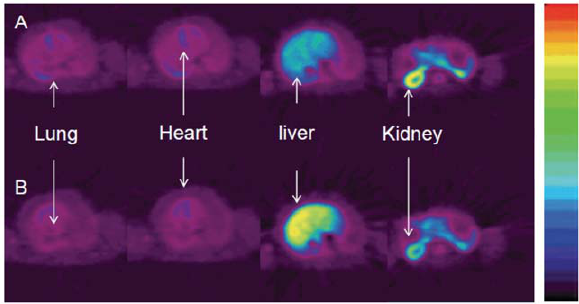
Figure 1. Summed images of tracer 1 (A, top) and tracer 2 (B, bottom) in lung, heart, liver and kidney (from 0 to 60 min) in baboon (April). Tracer 1 had the highest uptake in kidney; tracer 2, had the highest uptake in